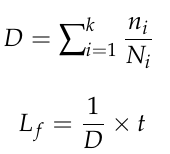
stress and stress amplitude using Goodman’s equation (Equation (9)).